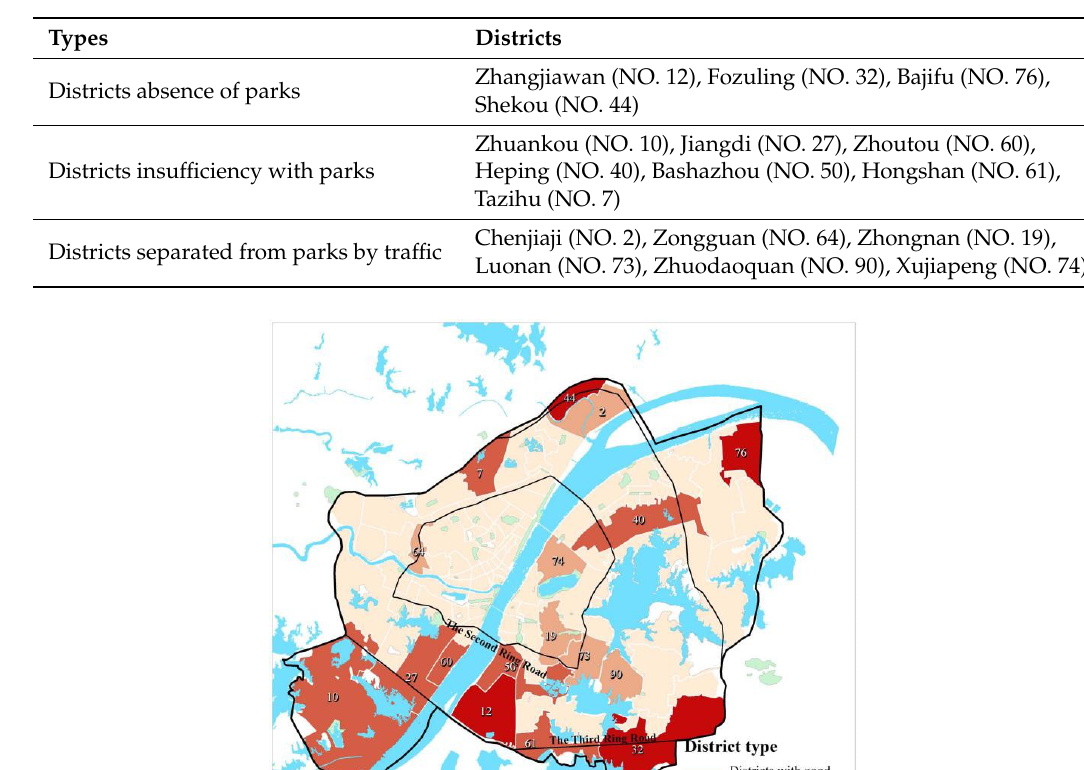
Table 5. Typical district classification.